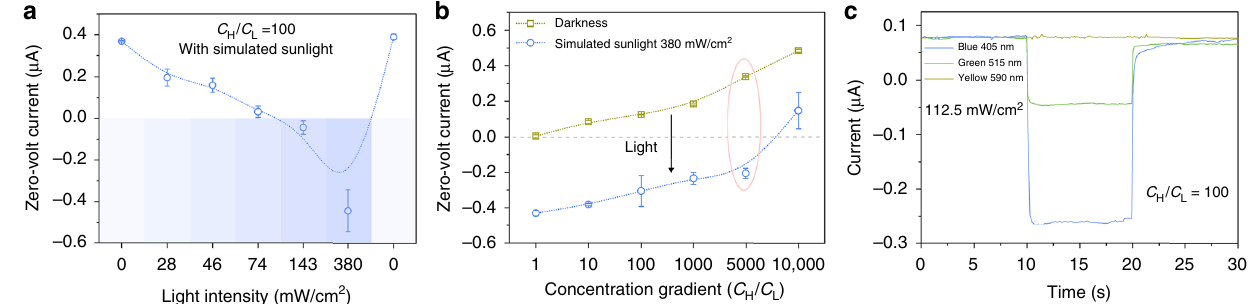
Fig. 2 High-performance arti fi cial ion pump. a Zero-volt current as a function of light density from 0 to 380 mW/cm 2 . Only the light density stronger than 74 mW/cm 2 can change the direction of ionic current at 100-fold KCl concentration gradient. b Zero-volt current as a function of concentration gradient from 1 fold to 10,000 fold. The CNNM-based ion pump can realize ions “ uphill ” transport process at up to 5000-fold concentration gradient. c Zero-volt current as a function of monochromatic light (blue: 405 nm; green: 515 nm; yellow: 590 nm) at 100-fold KCl concentration gradient. The ionic current is consistent with the light absorbance. Error bars represent standard deviations from fi ve independent experiments NATURE COMMUNICATIONS| (2019) 10:74